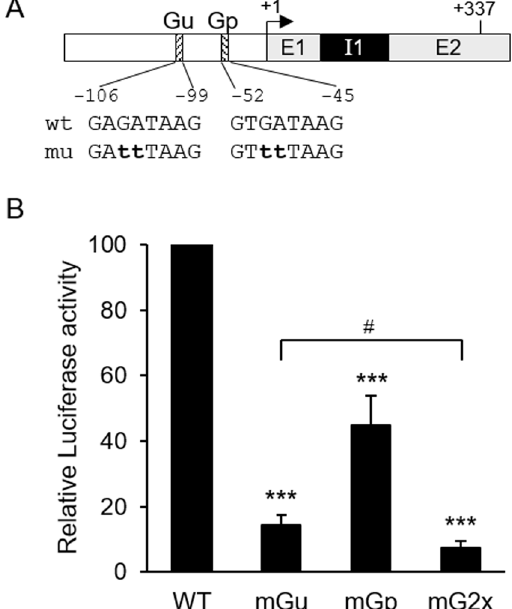
Figure 2. Enhancement of the transcriptional activity of the HSD3B1 promoter by two putative GATA sites. ( A ) Schematic of the promoter region in the HSD3B1 gene. “ + 1” is the transcription start site indicated by the arrow. Two putative GATA-binding sites are indicated as Gu and Gp. Their sequences are shown with mutated nucleotides in lowercase letters. E1, exon 1; I1, intron 1; E2, exon 2. ( B ) JEG-3 cells were transiently transfected with the − 238/ + 337 HSD3B1 promoter-luciferase construct containing wild-type or mutated GATA sites (either or both sites). Cells were harvested after 24 h of transfection and assayed for luciferase activity. Results are presented as the activity relative to the wild-type construct. Data are means ± SD of five